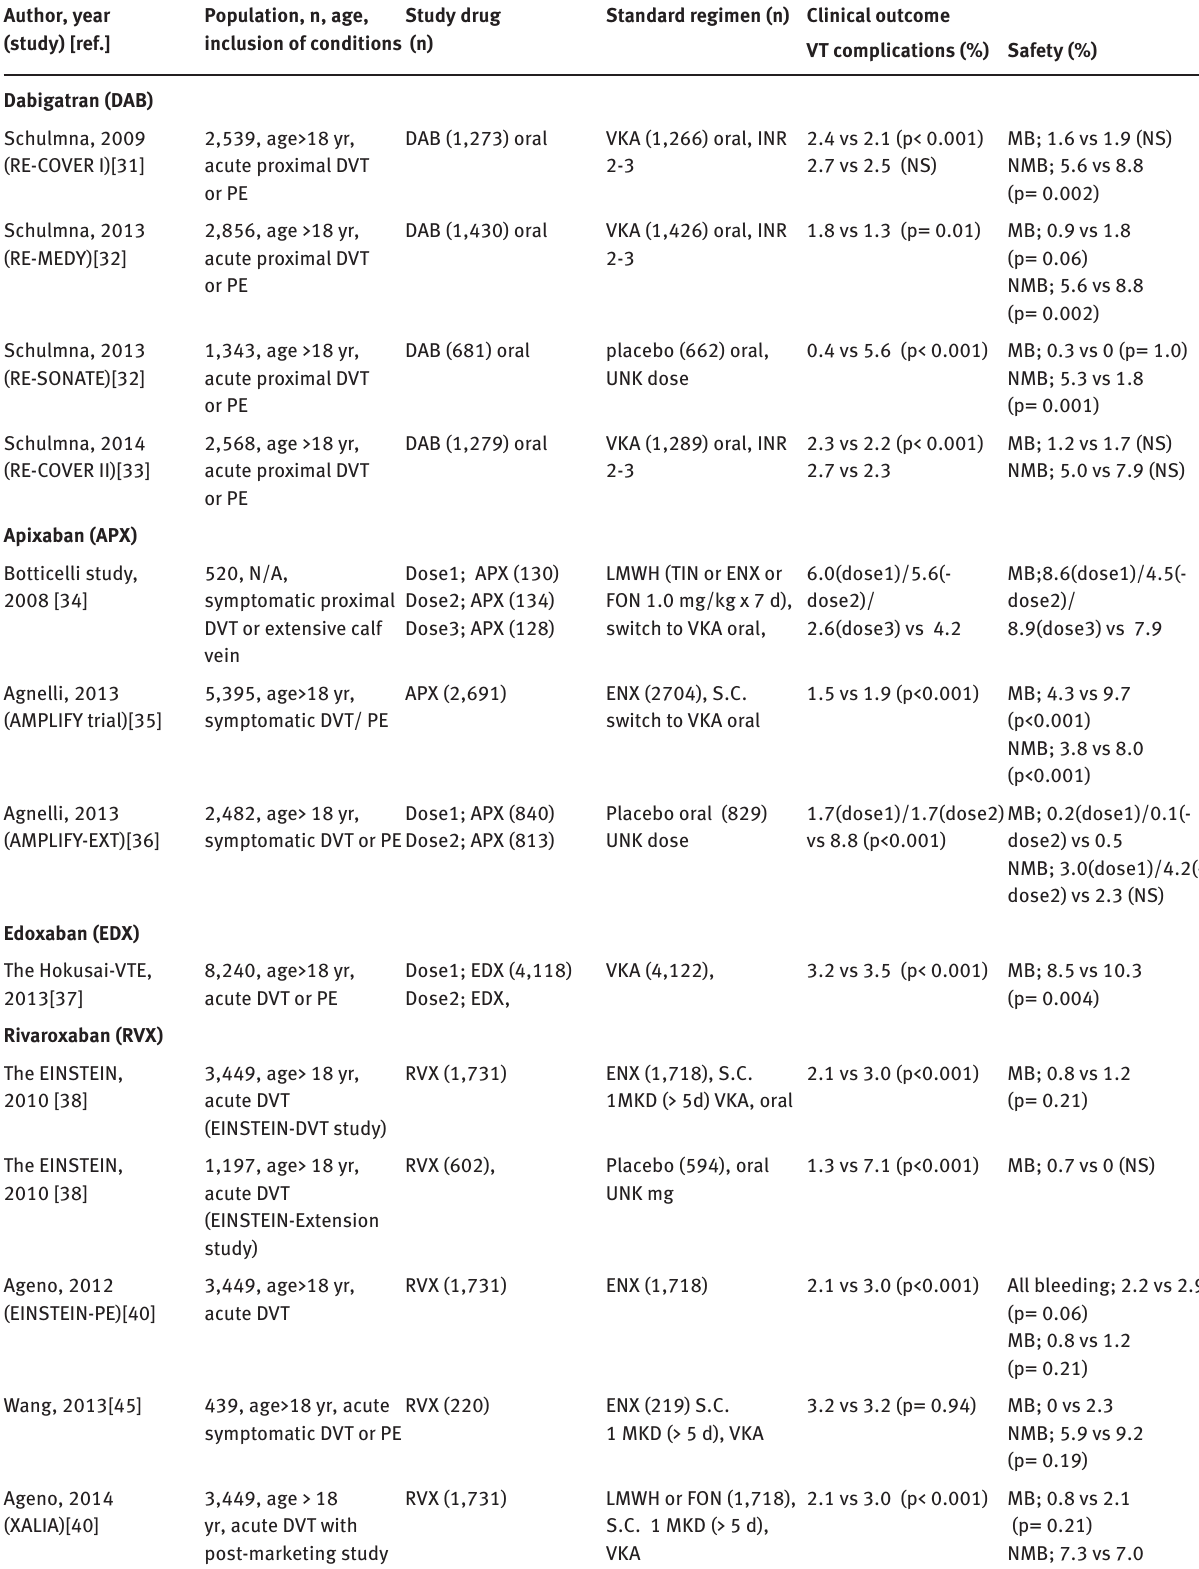
Table 2: Clinical data on the use of direct oral anticoagulants in the treatment of venous thrombosis Author,